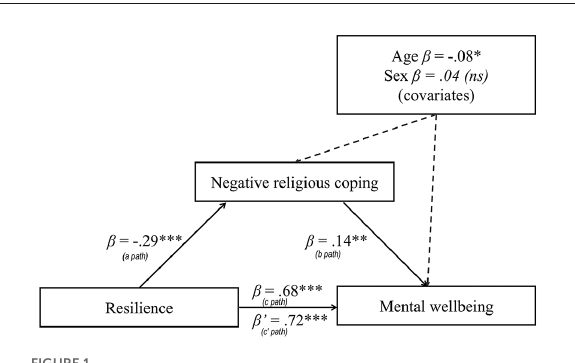
FIGURE1 Negative religious coping as mediator in relationship between resilience and mental well-being (age and sex as covariates).